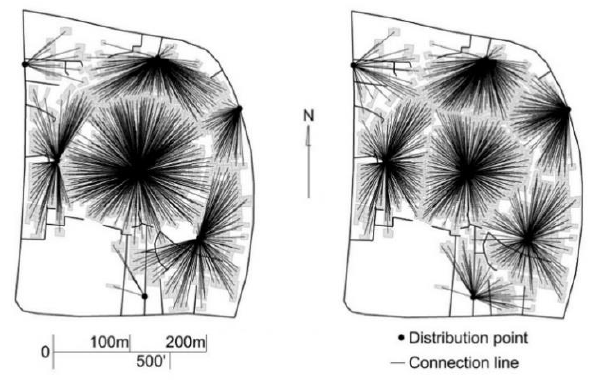
Figure 10. The initial distribution graph (left). Figure 11. Proximity adjusted distribution graph (right).